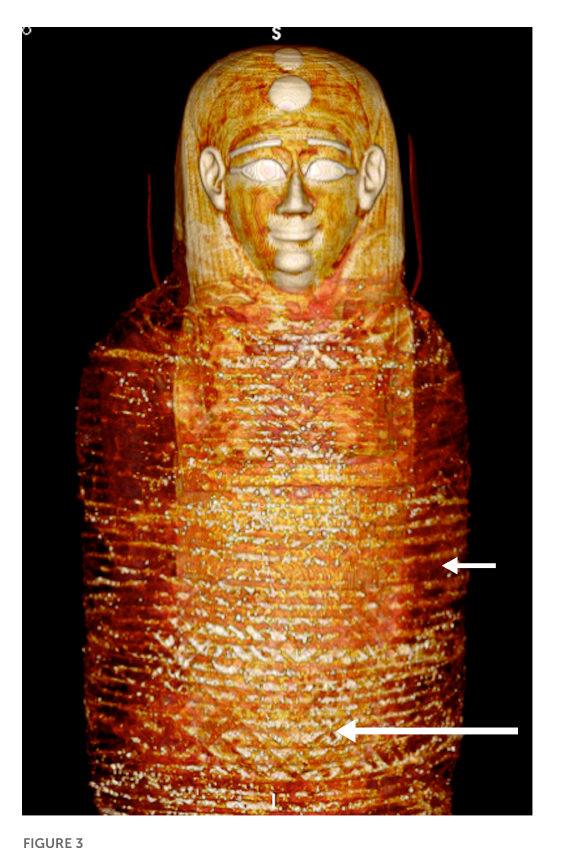
FIGURE3 Three-dimensional computed tomography (CT) image of the front of the head and torso of mummy TR 21/11/16 at the Cairo Egyptian Museum showing the head mask and the most outer bandages arranged transversely (short arrow) and diagonally in a criss-cross orientation (long arrow).